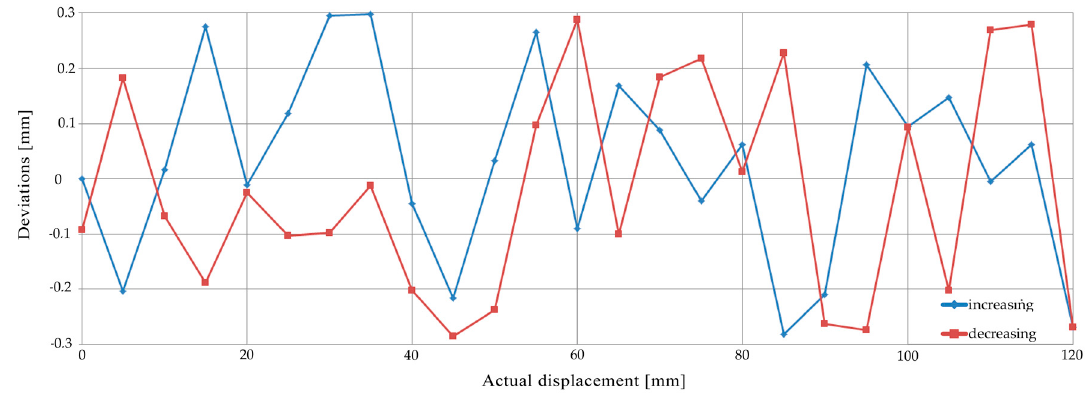
Figure 3. The deviations between the displacements obtained by the software and those from the displacements produced.